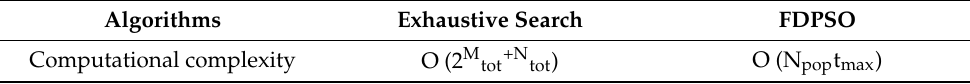
Table 1. Computational complexity